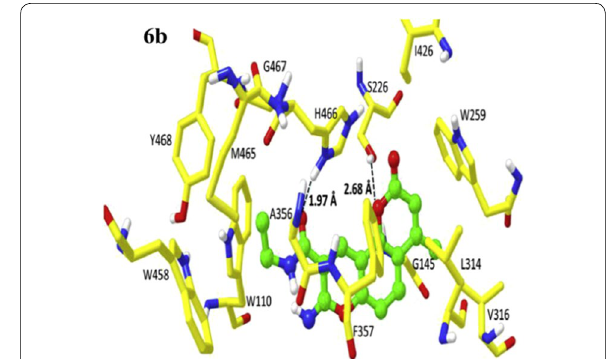
Fig. 32 Docking pose of compounds C22 at the binding site of BuChE [49]